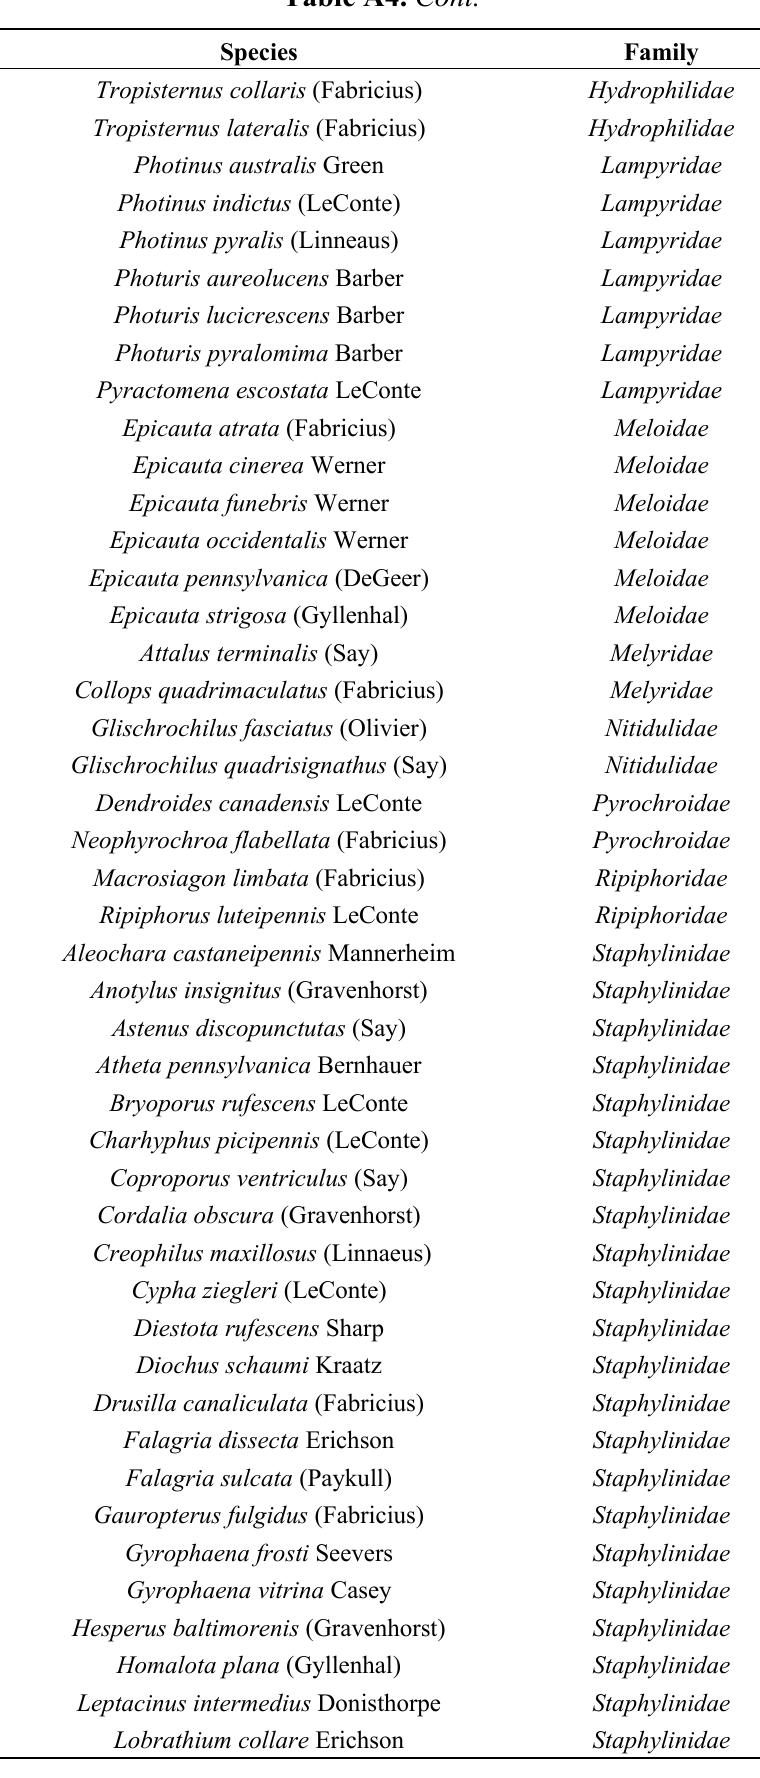
Table A4. Cont. Species Family Tropisternus collaris